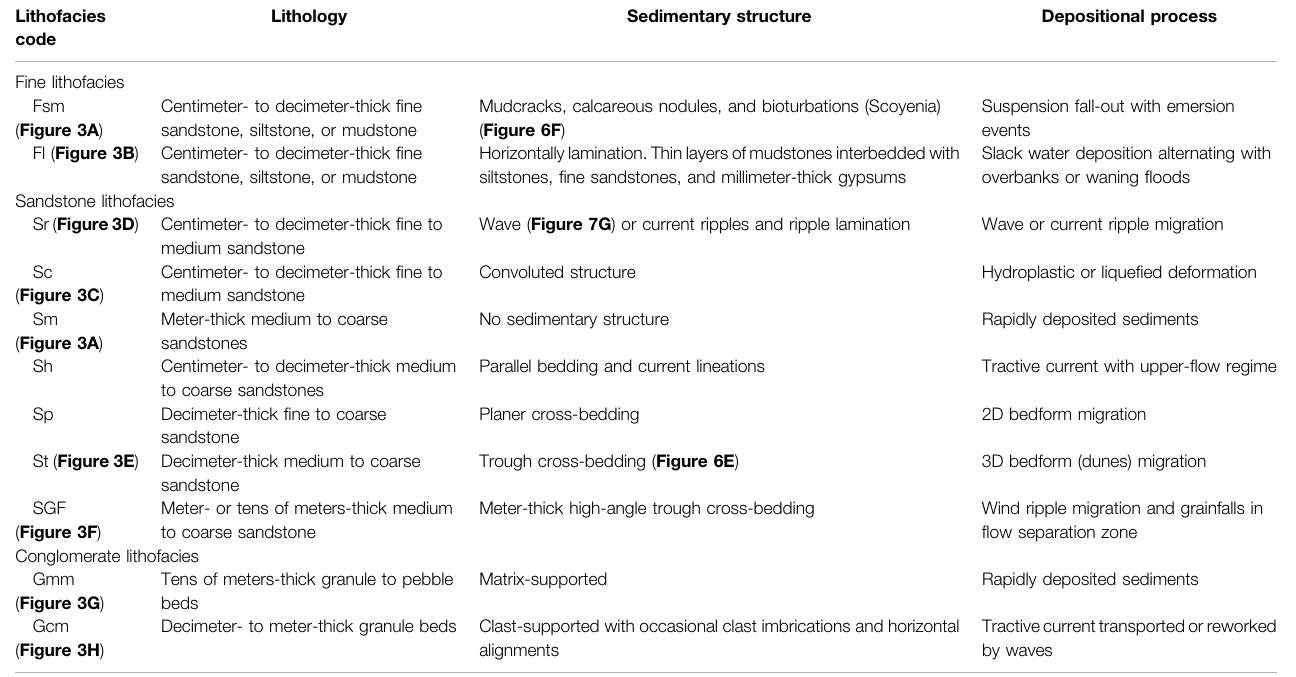
TABLE 1 | Lithofacies of the Qigu, Kalazha, and Qingshuihe Formations in the late Mesozoic Southern Junggar